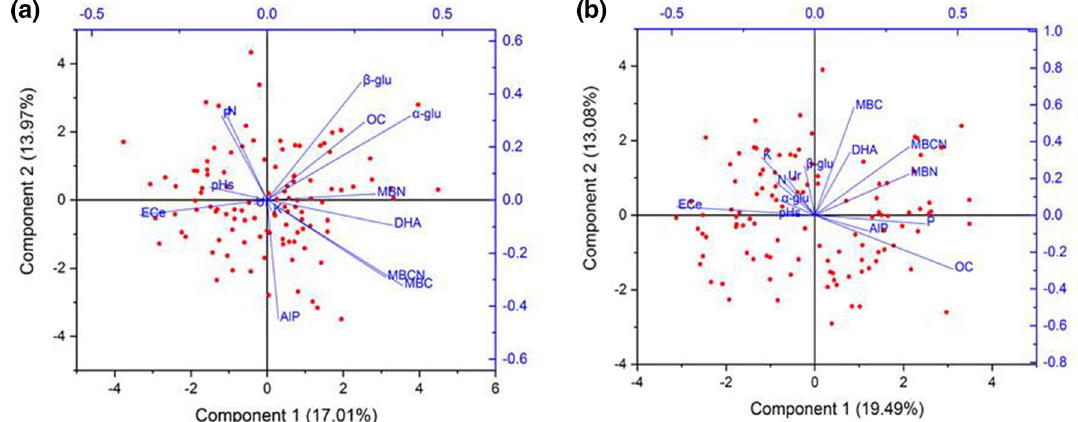
Figure 3. Graphic biplot for principal components (PC1 and PC2) for soil properties after harvest of sorghum ( a ) and wheat ( b ) [EC e , electrical conductivity of soil water saturation paste extract; pH s , pH of soil water saturation paste; WBOC, Walkley and Black organic carbon; MBC, microbial biomass carbon; MBN, microbial biomass nitrogen; MBCN, microbial biomass carbon to nitrogen ratio; DHA, dehydrogenase; AlK, alkaline phosphatase; Ur, urease; α -glu, α -glucosidase; β -glu, β